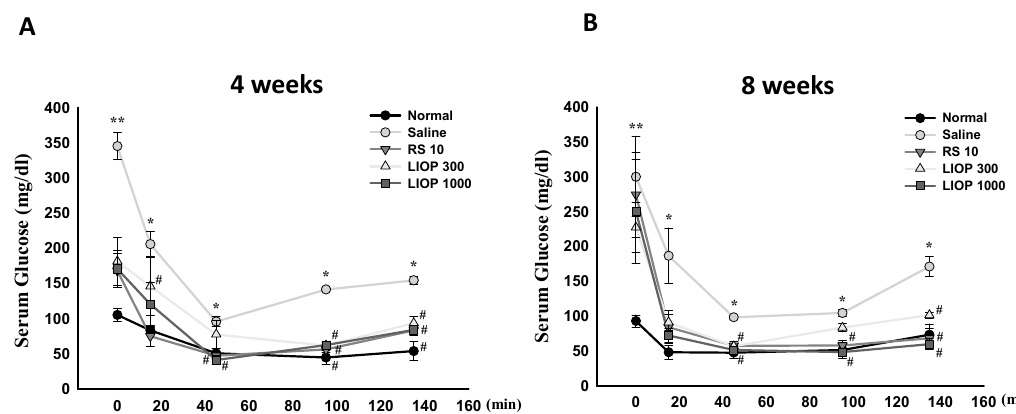
Figure 3. ITT Patterns of LIOP. After an overnight fast, 0.5 U insulin was administered orally to C57BL/6 mice with HFD + STZ-induced diabetic nephropathy. The effects of LIOP (300 and 1000 mg/kg) and rosiglitazone (10 mg/kg) treatment were compared to the effects of the saline-alone group at four ( A ) and eight weeks ( B ). The blood samples were taken 0, 15, 45, 95, and 135 min after administration of insulin, and glucose levels were measured in whole venous blood with a glucometer (One Touch II, Lifescan). The data are expressed as mean ± SE of eight mice. *: p < 0.05, **: p < 0.001 compared to normal group. #: p < 0.05, compared to saline group. ITT: insulin tolerance test; Normal: native control; Saline: vehicle control; RS: rosiglitazone; LIOP: Low-molecular-weight, 10–100 kDa polysaccharides from Inonotus obliquus